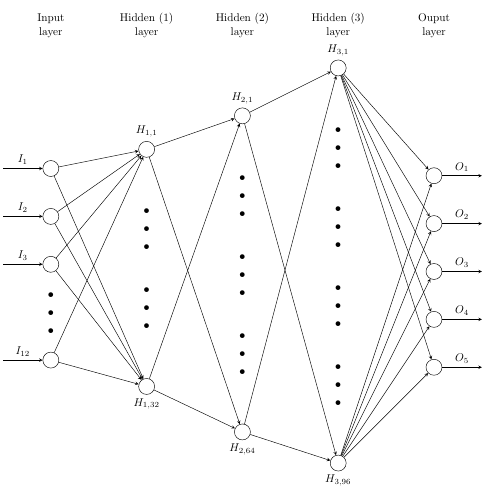
Figure 2. Deep neural